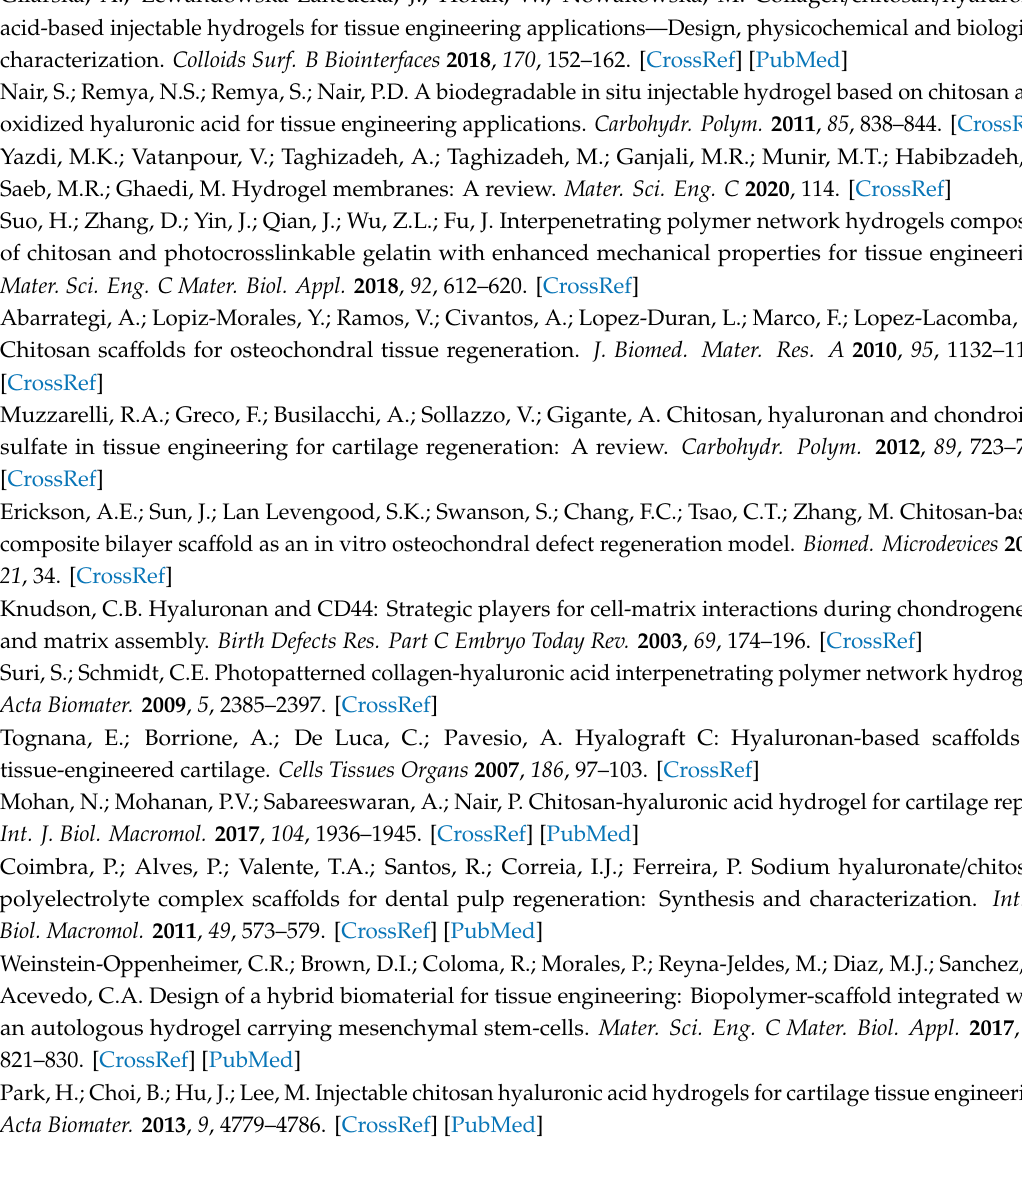
Figure S1: (A) 1 H-NMR spectrum of HAMA with 4.5% methacrylation degree in D 2 O, and (B) ATR-FTIR spectra of HA and HAMA, Figure S2: ATR-FTIR spectra of Ch, Ch / HA, and Ch / HAMA